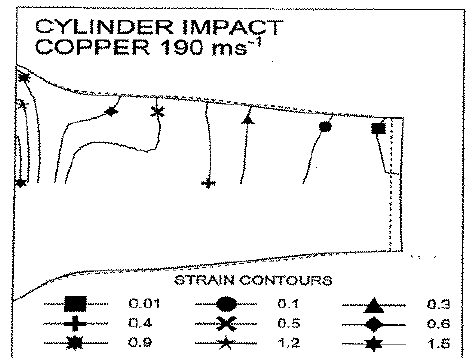
Figure 3. Comparison of calculated (continuous curve) and (dotted) experimental shapes for a longitudinal section of an impacted copper solid cylinder, including internal iso-strain profiles [10].